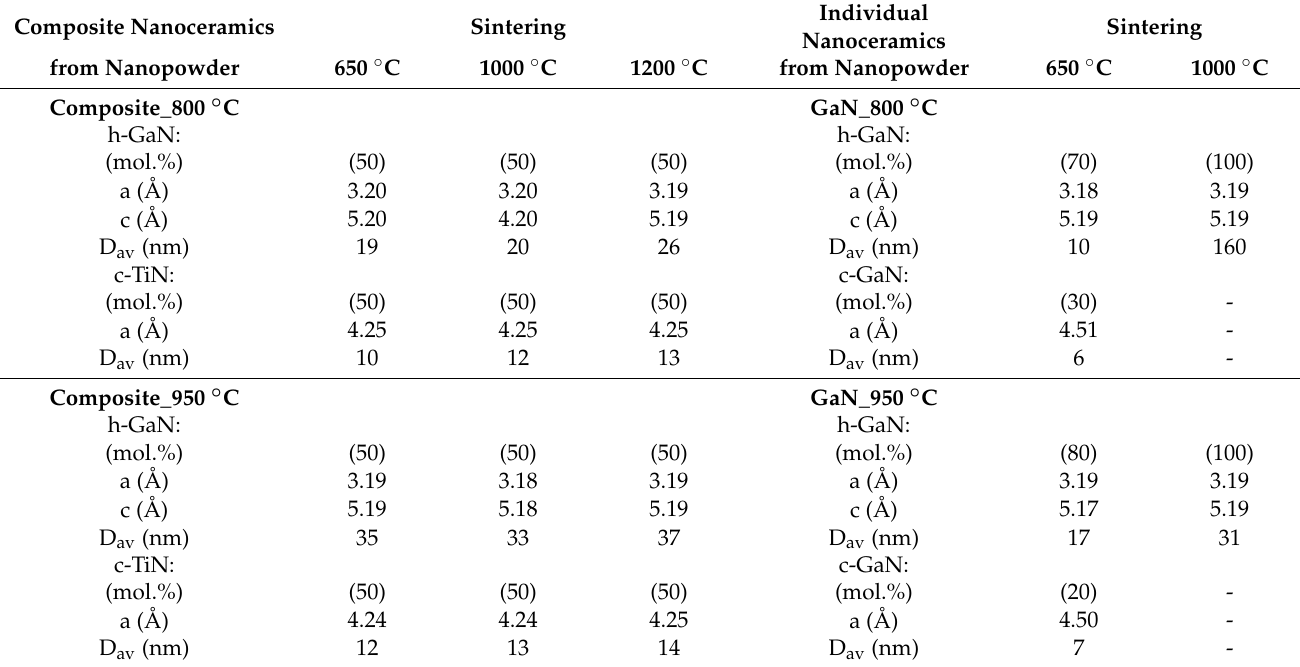
Table 2. XRD-derived crystallographic cell parameters a and c and average crystallite sizes D av ’s determined for composite nanoceramics in the system GaN–TiN sintered at 650, 1000, and 1200 ◦ C and pure GaN nanoceramics sintered at 650 and 1000 ◦ C. Note that relevant cases of individual TiN nanoceramics are included in